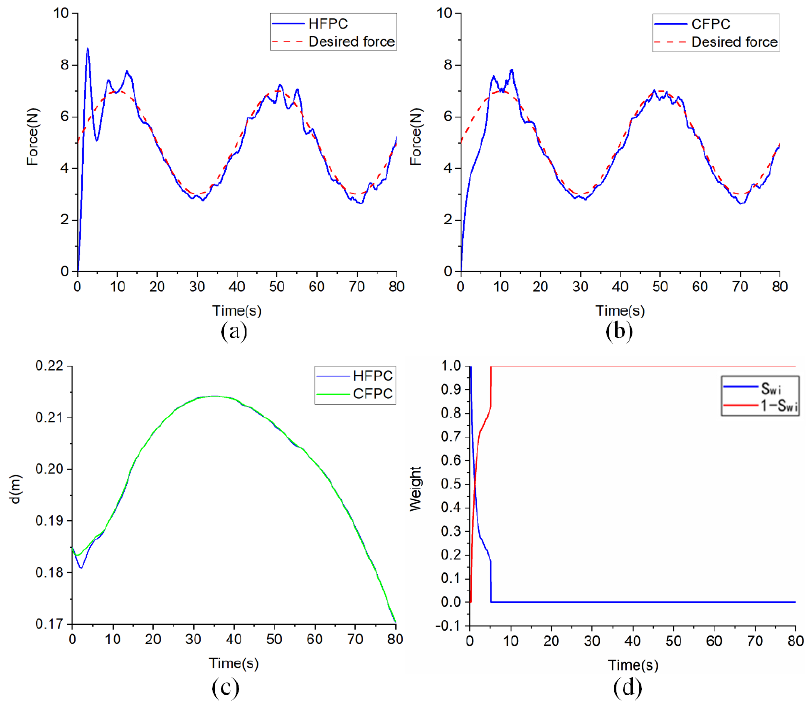
Figure 13. Variable force-tracking experiment on a curved surface. Force tracking using ( a ) the HFPC and ( b ) proposed CFPC methods. ( c ) Position tracking. ( d ) Weighted parameter wi s .